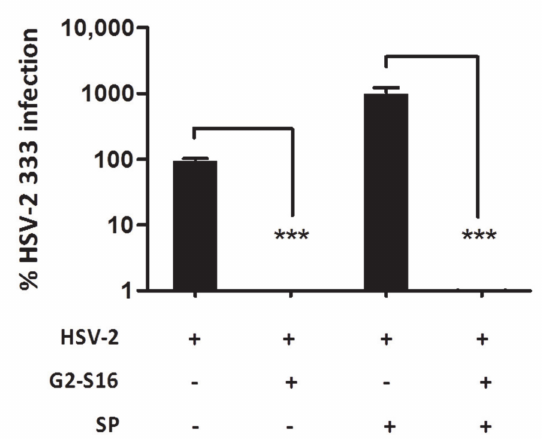
Figure 2. Inhibition of HSV-2 in the presence of semen. Vero cells were pretreated with a non-toxic concentration of G2-S16. After 1 h cells were infected with HSV-2 in the presence or absence of seminal plasma (SP). Data represent mean ± SD from three independent experiments by duplicate. ***: p < 0.001. Infection was revealed by plaque reduction assay. HSV-2 infection at MOI 0.001 was used as infection control, and data were related to control. +/ -: Presence or absence of